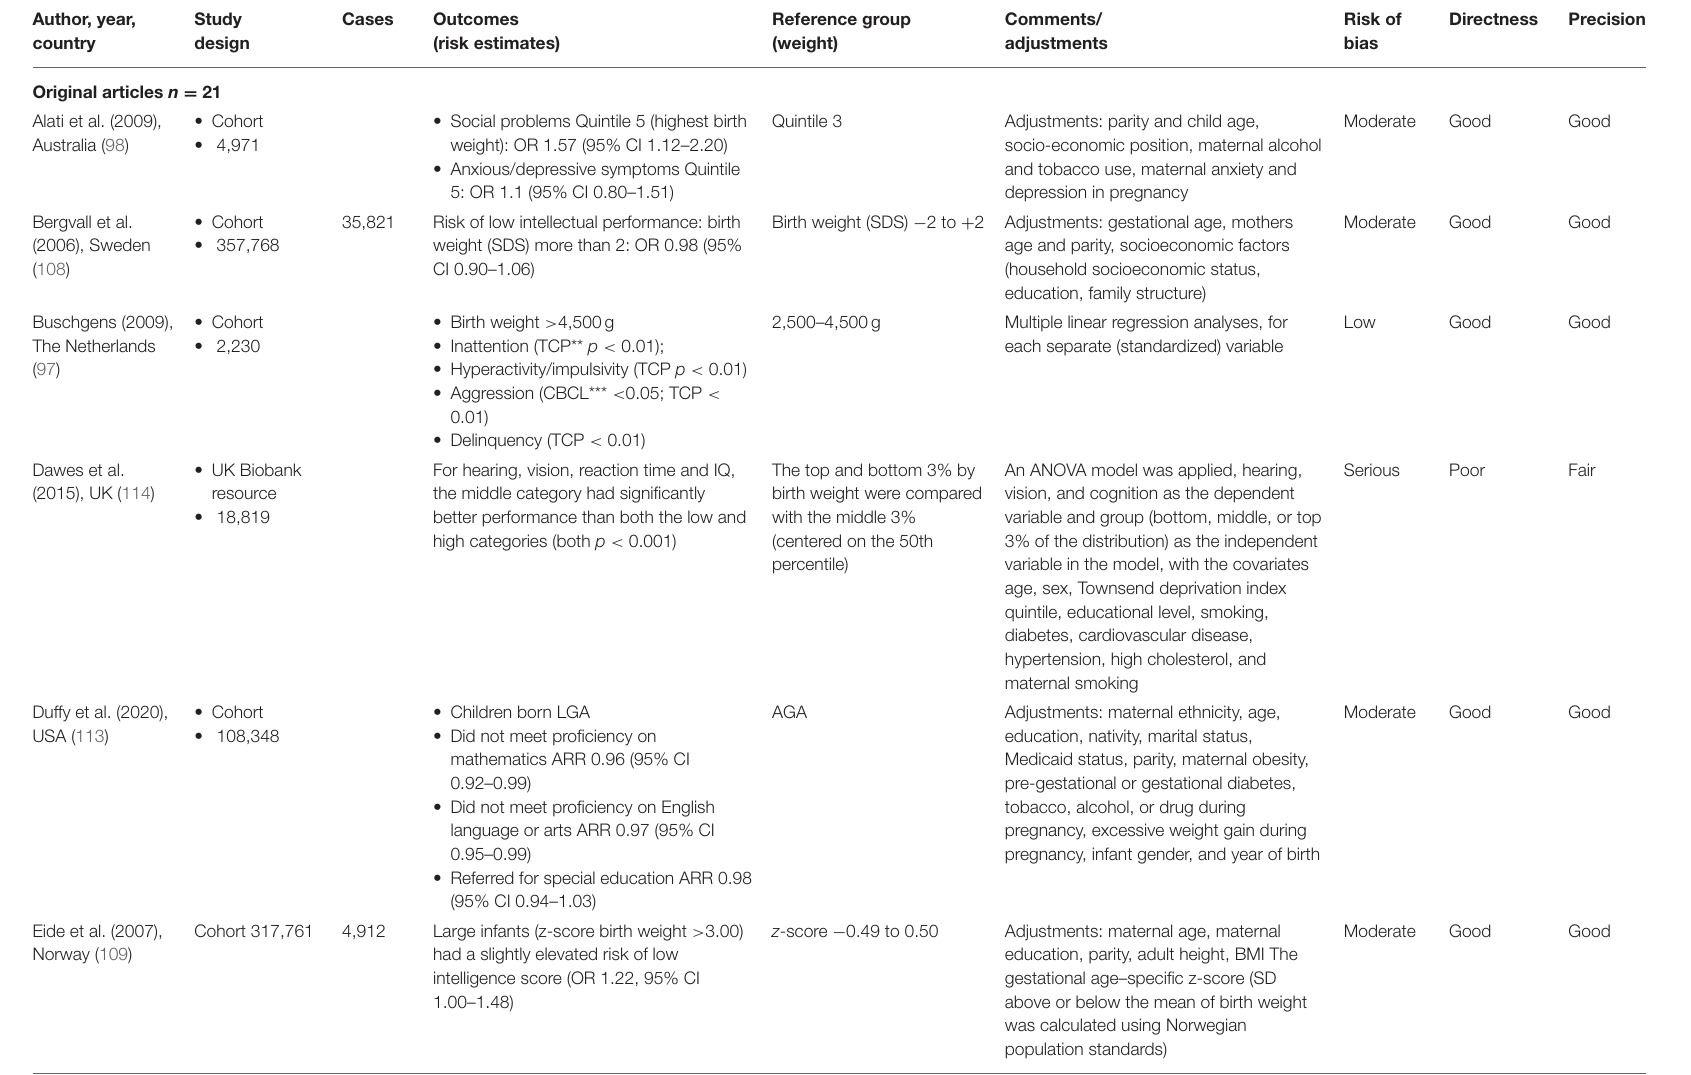
TABLE 1.2b | LGA, high birth weight, and long-term outcomes—cognitive